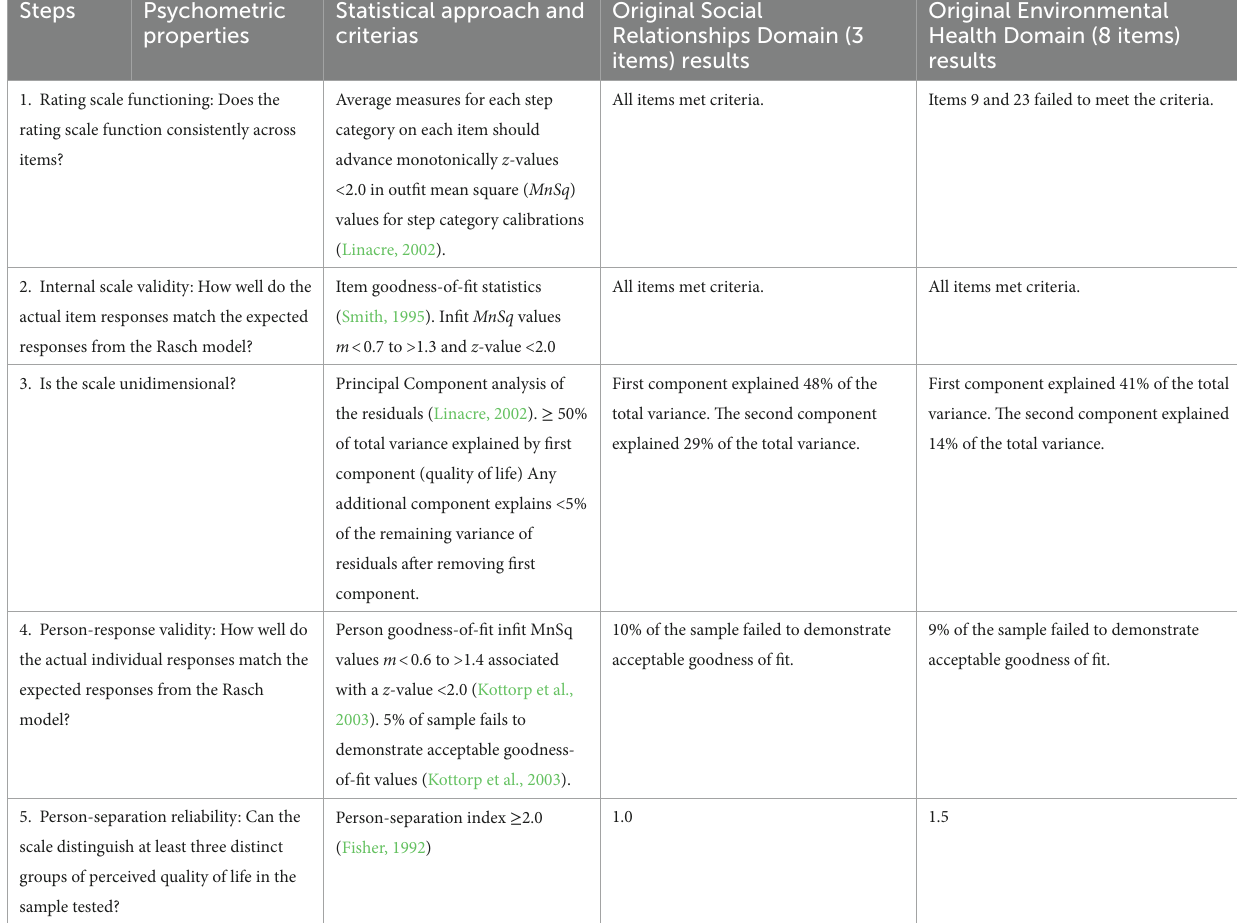
TABLE 5 Psychometric properties of the social relationships and environmental health domain of the WHOQOL-BREF scale.